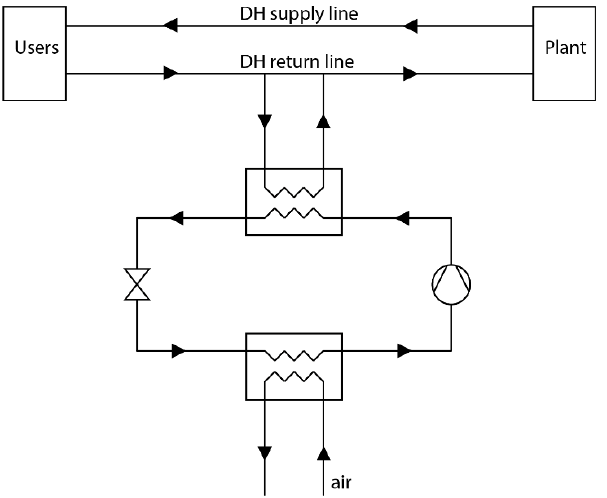
Figure 3. Schematic of a DH integrated HP with source-return configuration.